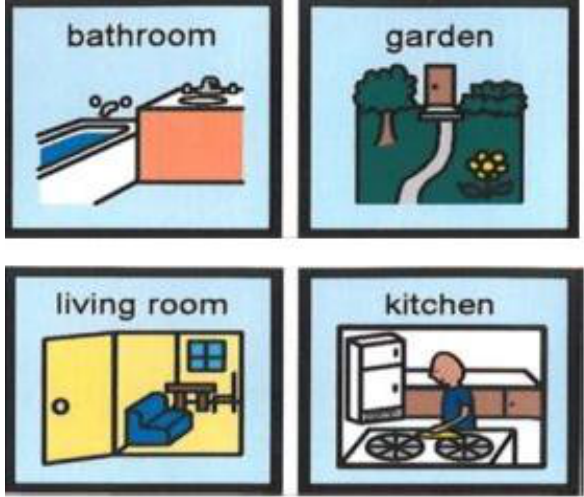
Figure 3. Symbols used for the four Topics. The Picture Communication Symbols ©1981–2012 Dynavox Mayer Johnson are used with permission. All rights reserved worldwide.